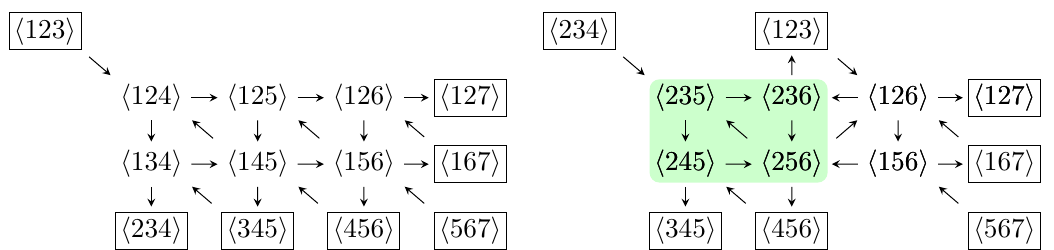
Figure 12. The Conf 7 ( P 2 ) initial cluster (left) and the cluster resulting from a cyclic mutation of a Conf 6 ( P 2 ) subalgebra, highlighted in green (right). Conf 7 ( P 2 ) (cid:24) Conf 7 ( P 3 ) but we have given this example to demonstrate this procedure is valid for Conf n ( P k (cid:0) 1 ) 8 k; n